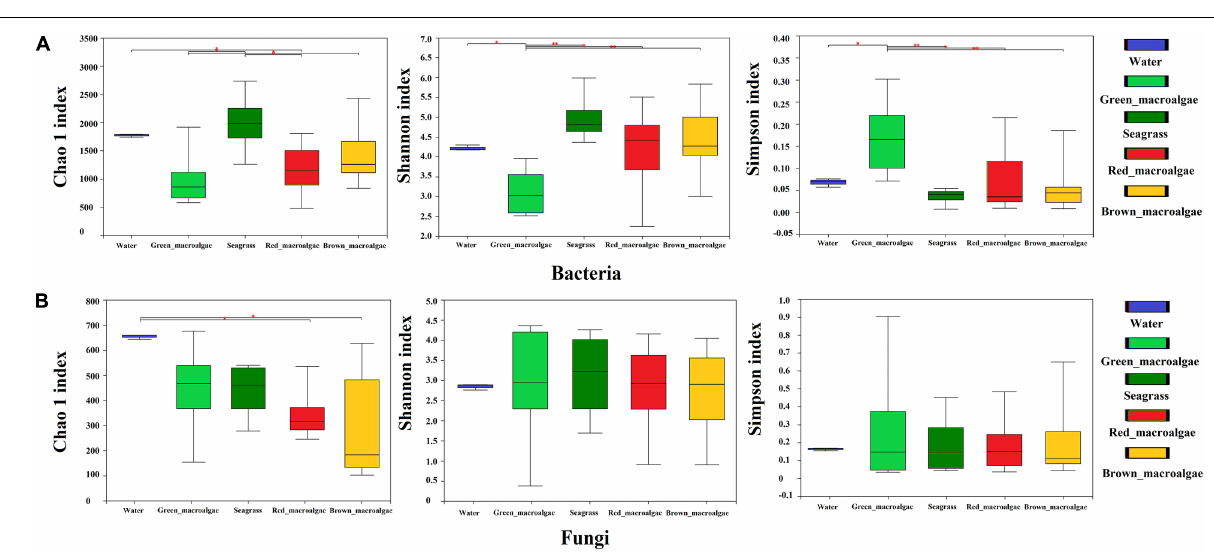
FIGURE 3 | Alpha-diversity of the seawater, green macroalgae, red macroalgae, brown macroalgae, and seagrasses. (A) Alpha-diversity of the bacterial community. (B) Alpha-diversity of the fungal community. Statistical comparison of indicated data was performed using Wilcoxon rank-sum texts with ∗ ( P < 0.05), and ∗∗ ( P <